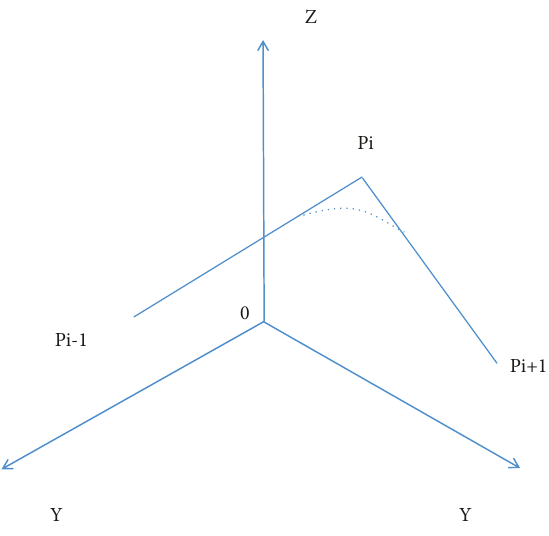
Figure 3: Schematic diagram of arc